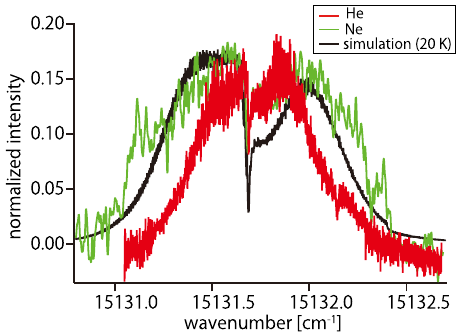
Fig. 3 Comparison of spectra at high temperatures. The red line is the spectrum of FBPc cooled with helium buffer gas at 5 K, similar to that in Fig. 1. The green line is the spectrum of FBPc cooled with neon buffer gas at 15 K. The black line shows simulation results at 20 K. Absorption intensities are normalized for clarity. Measurements at higher temperature gave broader spectra with wider rotational